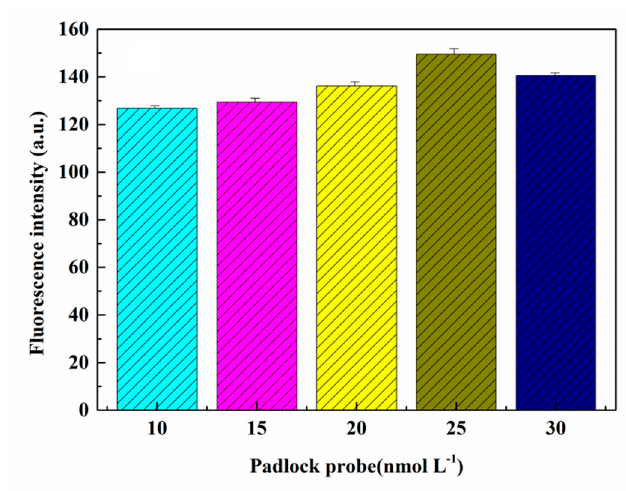
Figure 3. E ff ect of padlock probe concentration on fluorescence intensity. Figure 3. Effect of padlock probe concentration on fluorescence intensity. Figure 3. Effect of padlock probe concentration on fluorescence intensity.